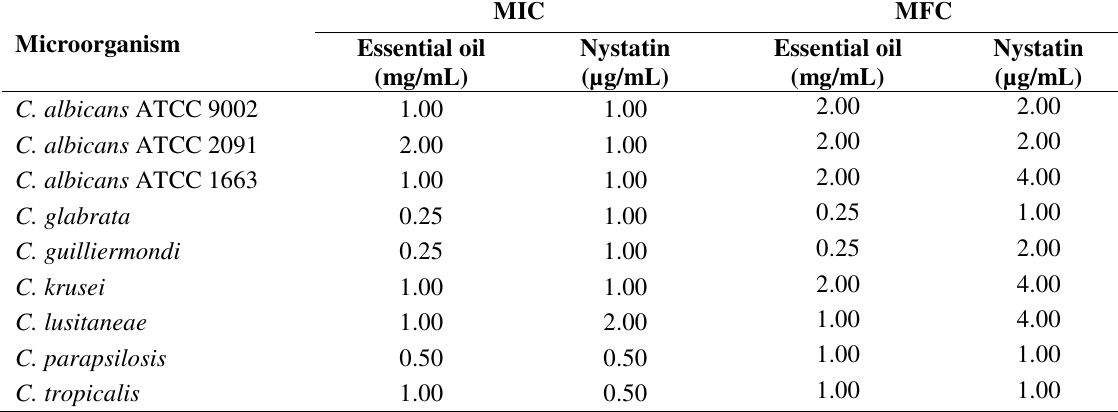
2. Minimum Inhibitory Concentrations (MIC) and Minimum Concentrations (MFC) of essential oil of C. ambrosioides on Candida strains. Microorganism